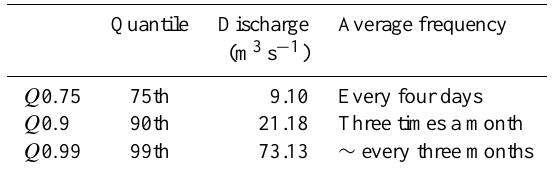
Table 1. Thresholds for the Sihl discharge in Zurich considered for the evaluation of the model